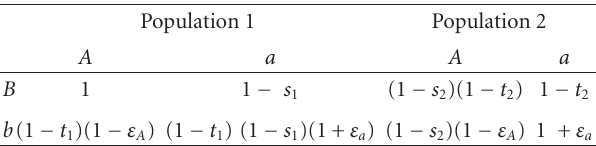
Table 3: Fitnesses of the four haplotypes in the full model. For Case 1, t 1 = t 2 =